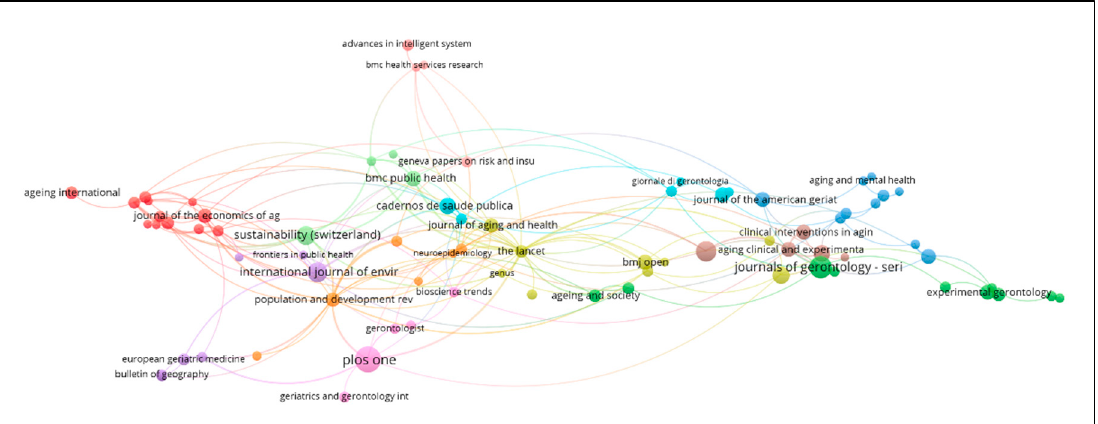
Figure 5. Co-citation analysis of source titles network visualization map.